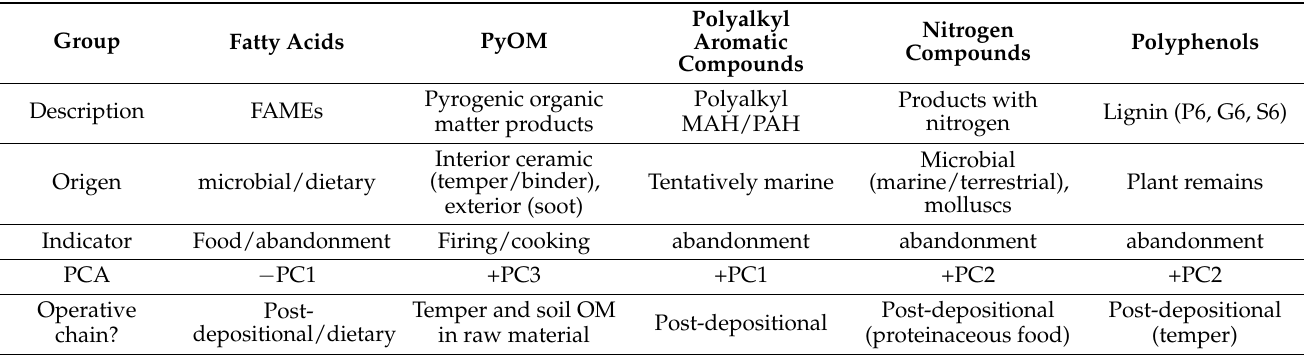
Figure 5. PC scores from THM-GC-MS after PCA. Colors indicate cultural periods (red: Neolithic, blue: Early Bronze Age; green: Middle Bronze Age, yellow: Late Bronze Age I, magenta: Late Bronze Age II). Table 2. Main organic matter types identified, with their likely origin (unlikely alternatives within parentheses) and their loadings on PC1-PC3 from the principal component analysis.